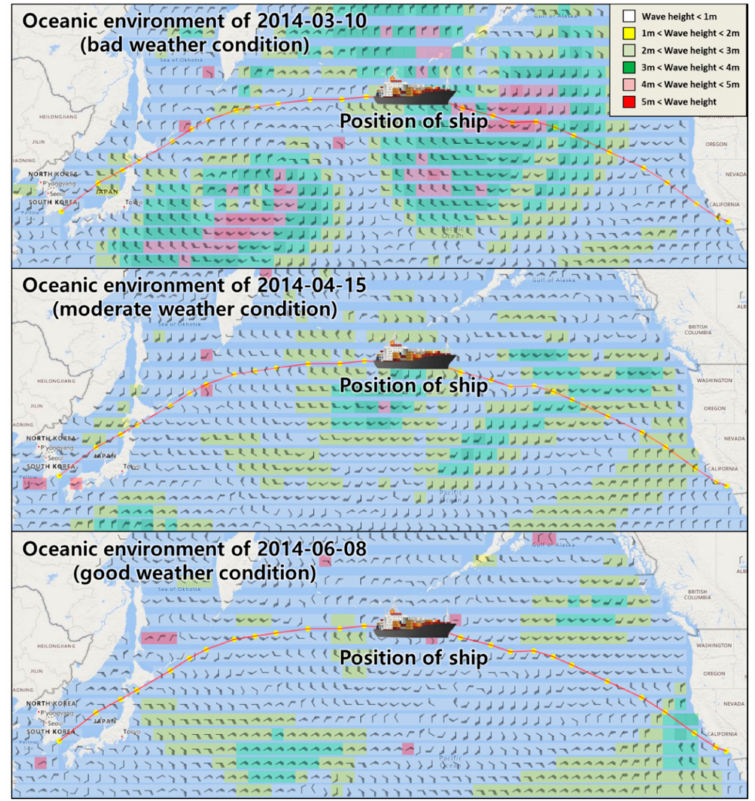
Figure 10. The representative oceanic environment of cases.